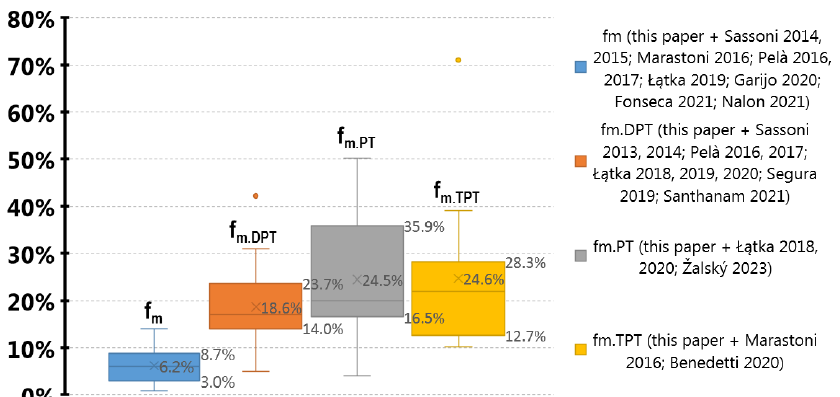
Figure 22. Comparison of variation coefficients (CV) for all analyzed tests from the literature [3,19,20,22,28,35,41,44–46,49–52,58,60,61] and presented herein. Total number of 140 CVs was included—64 for f m ; 43 for f m.DPT ; 19 for f m.PT ; 14 for f m.TPT . The horizontal line represents median, and x represents mean. All MDTs are characterized by much wider dispersion in comparison with DT. The widest range of CV was noted for penetrometric test. The right skewed distribution characterized all CV tests.